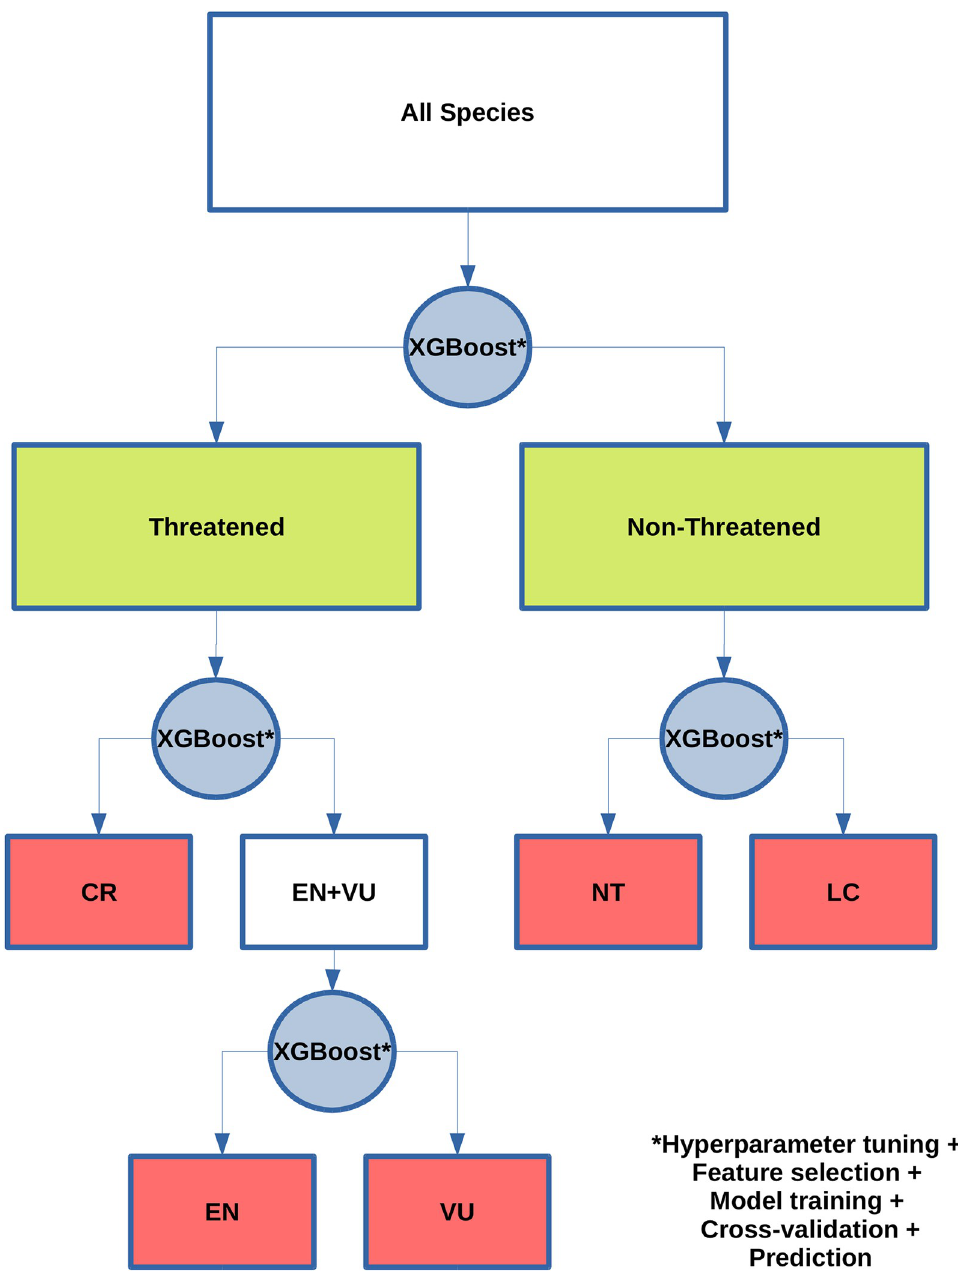
Fig 5. Flowchart for classification tasks in automated extinction risk assessment method, using the XGBoost algorithm [29]. Green boxes represent outcomes of the binary task and red boxes represent the outcome of the specific tasks. Steps taken for each classification task (blue circle) are indicated after the asterisk. CR, Critically Endangered; EN, Endangered; LC, Least Concern; NT, Near Threatened; VU,